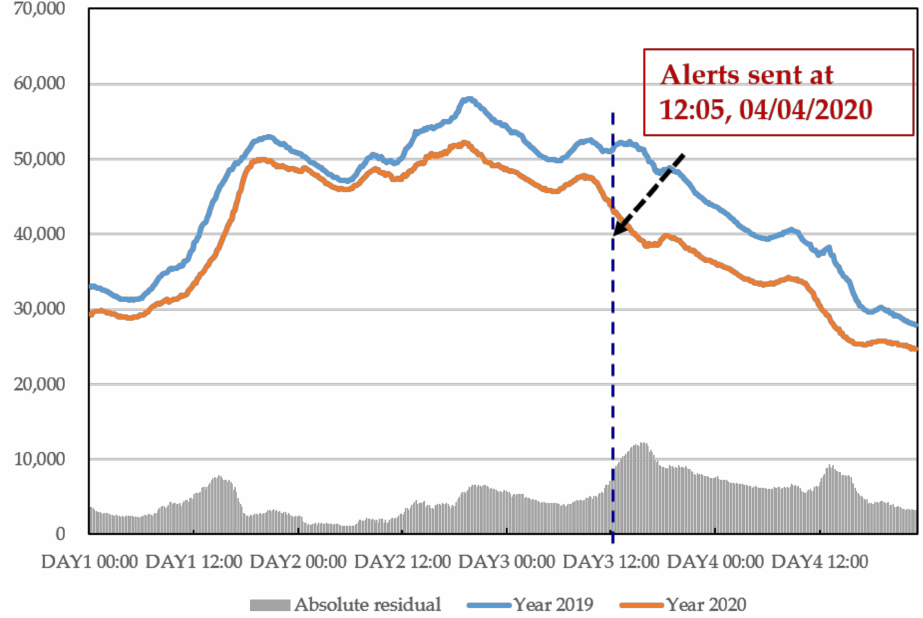
Figure 9. Crowd distributions in Hengchun Township over 4-day weekends in 2019 and